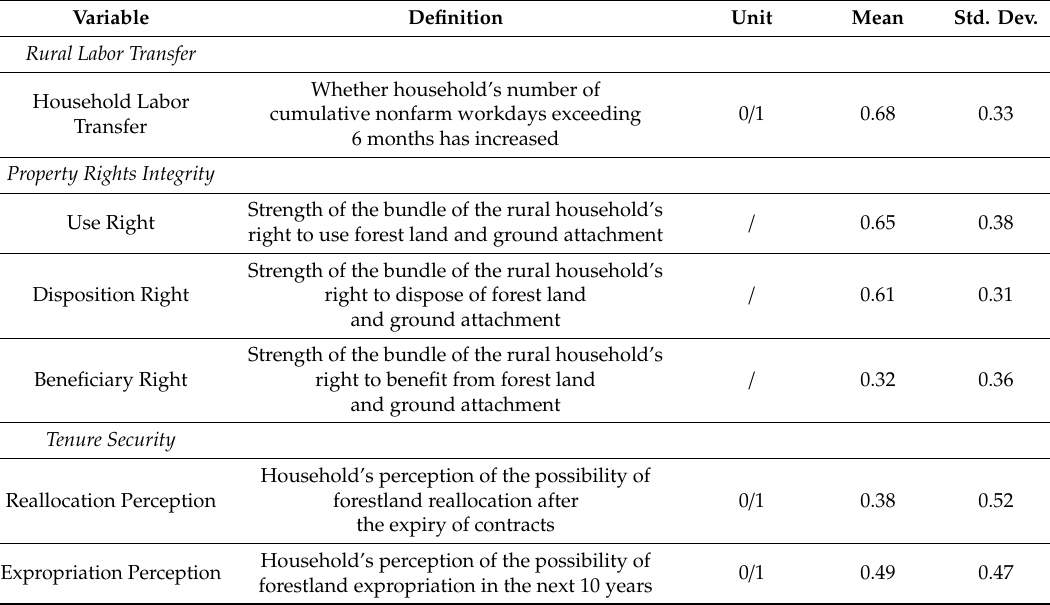
Table 2. Descriptive statistics of the data ( N =